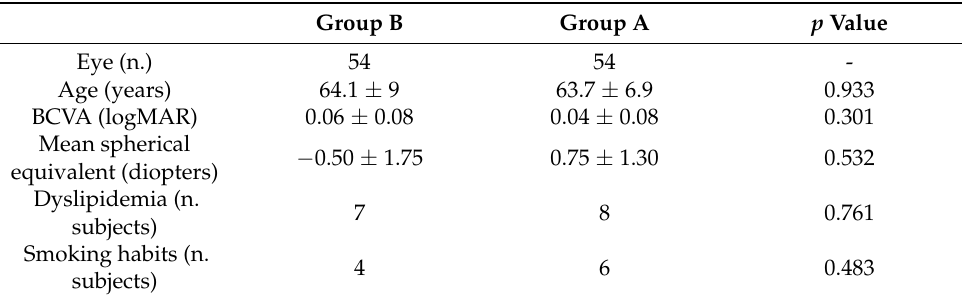
Table 1. Demographic and clinical characteristics in controls and patients.